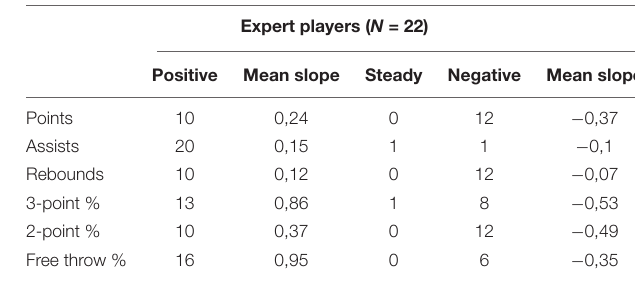
TABLE 1 | Mean slope and number of cases of each